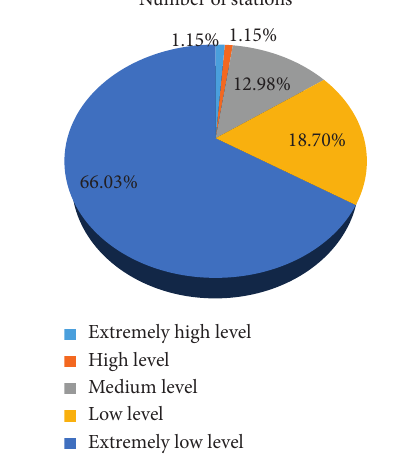
Figure 14: The levels of vulnerability under cascading